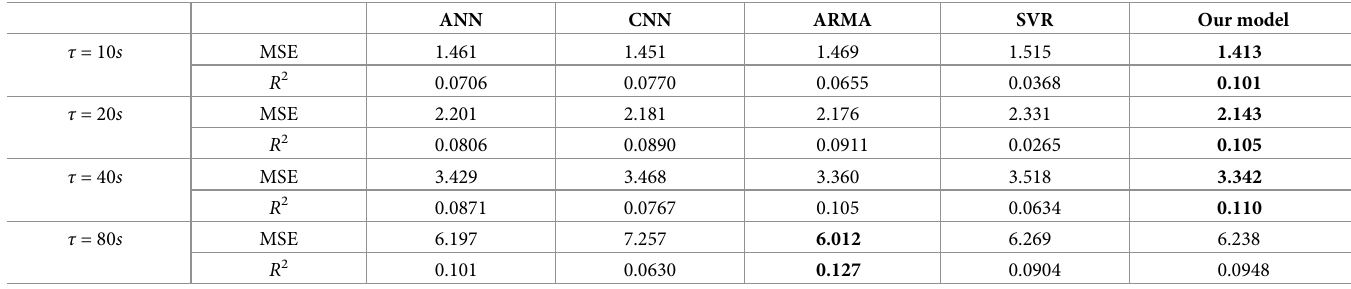
Table 3. The experiment result in BTC-e